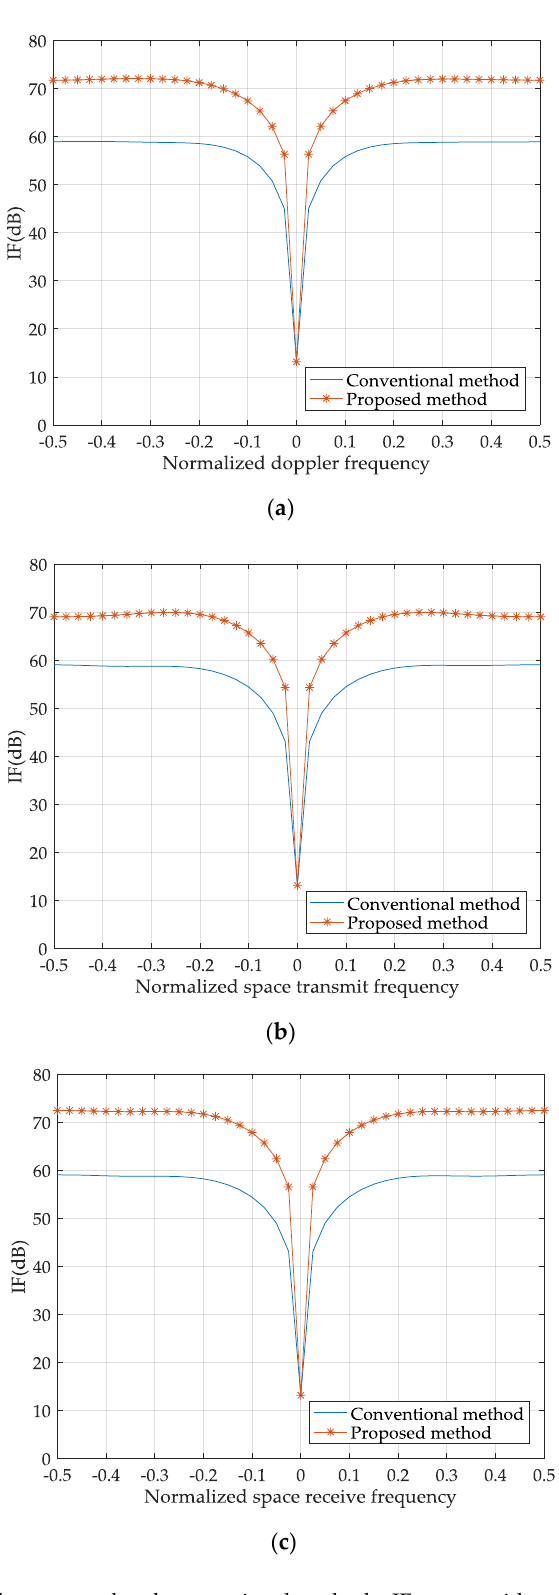
Figure 3. Variations of improvement factor (IF) with normalized frequencies. Results achieved by the proposed and conventional methods are shown in ( a ) and ( b ), respectively.